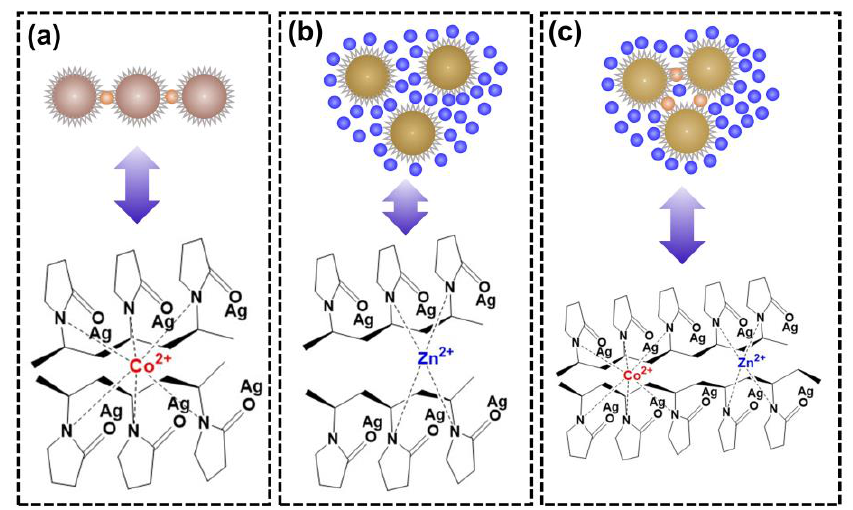
Figure 9. The coordination modes of PVP-AgNPs with metal ions in various solutions: ( a ) Co 2+ ; ( b ) Zn 2+ ; ( c ) mixture of Co 2+ and Zn 2+ .